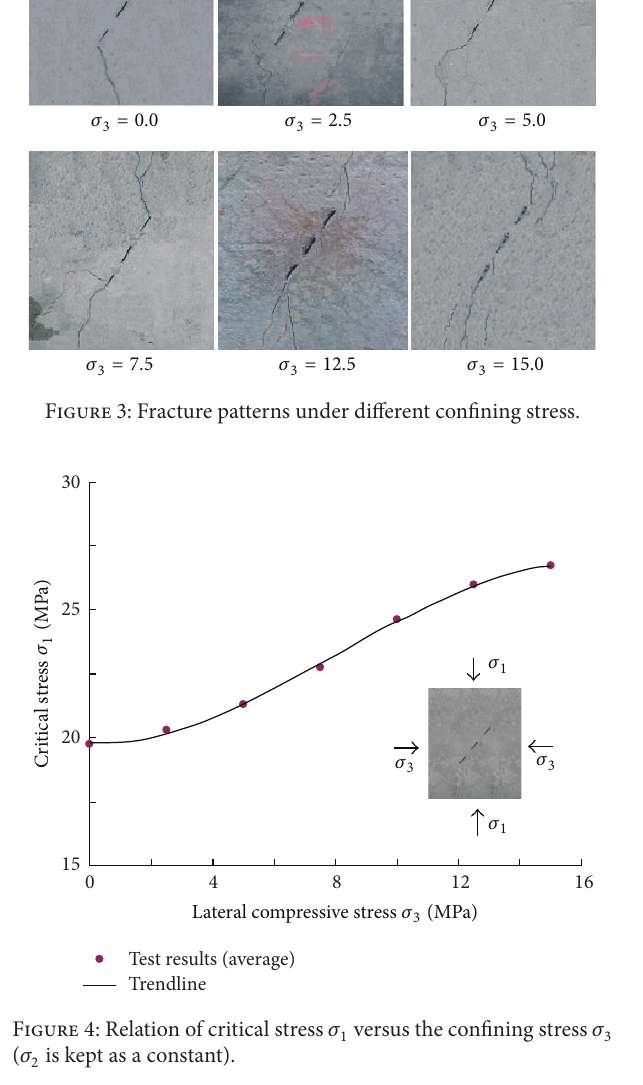
Figure 6: Relation of compressive strength 𝜎 1 with the crack inclination angle 𝛼